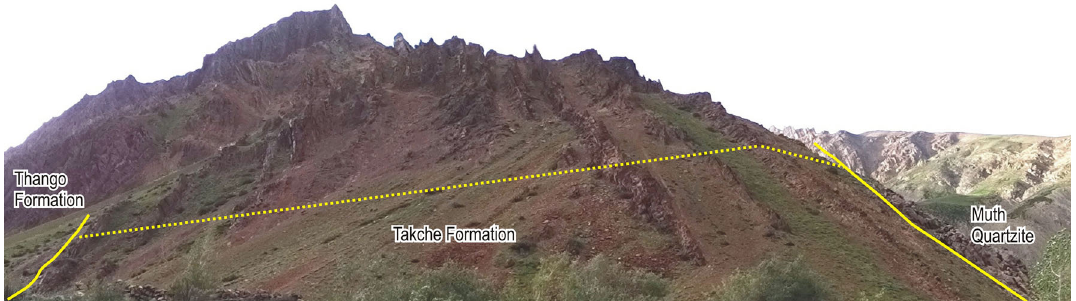
Fig. 2. Field photograph of the Gechang section in the Parahio Valley, Spiti,